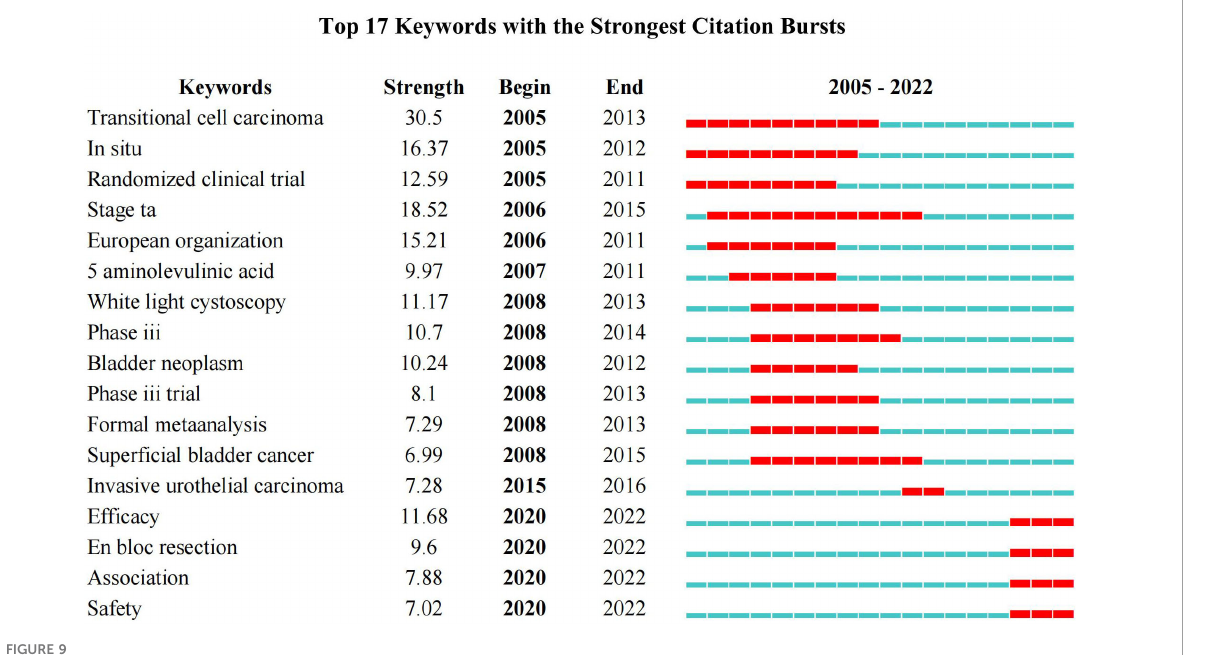
FIGURE 9 Keywords burst analysis by